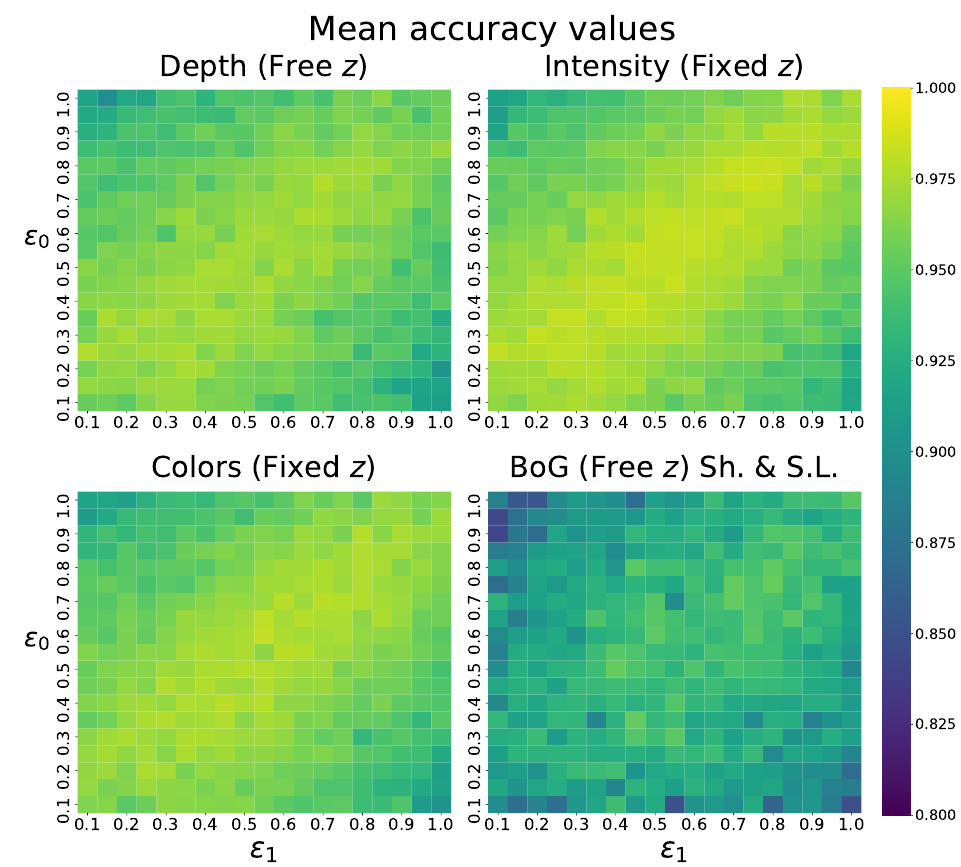
Figure 10. Visualization of mean accuracy values obtained on images of superquadrics with different ground truth shape parameter